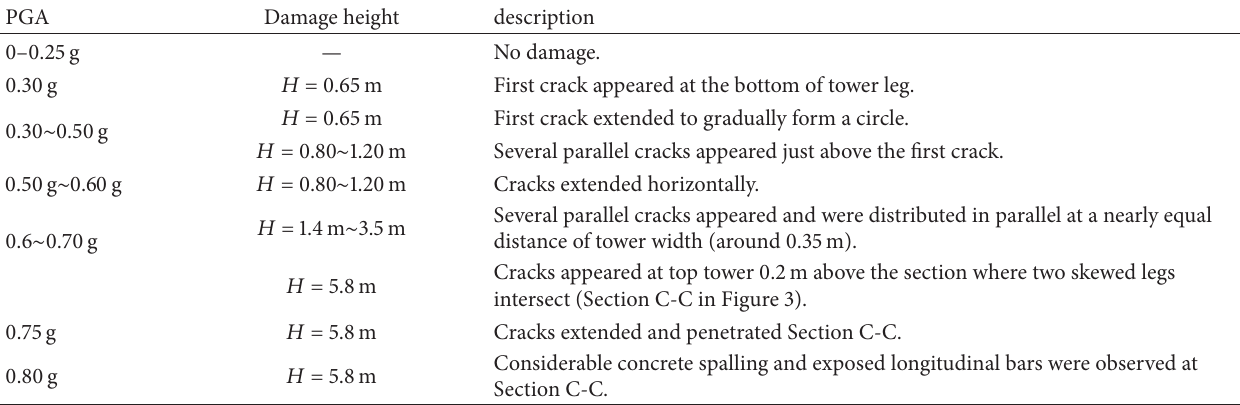
Table 6: Observed damage during the